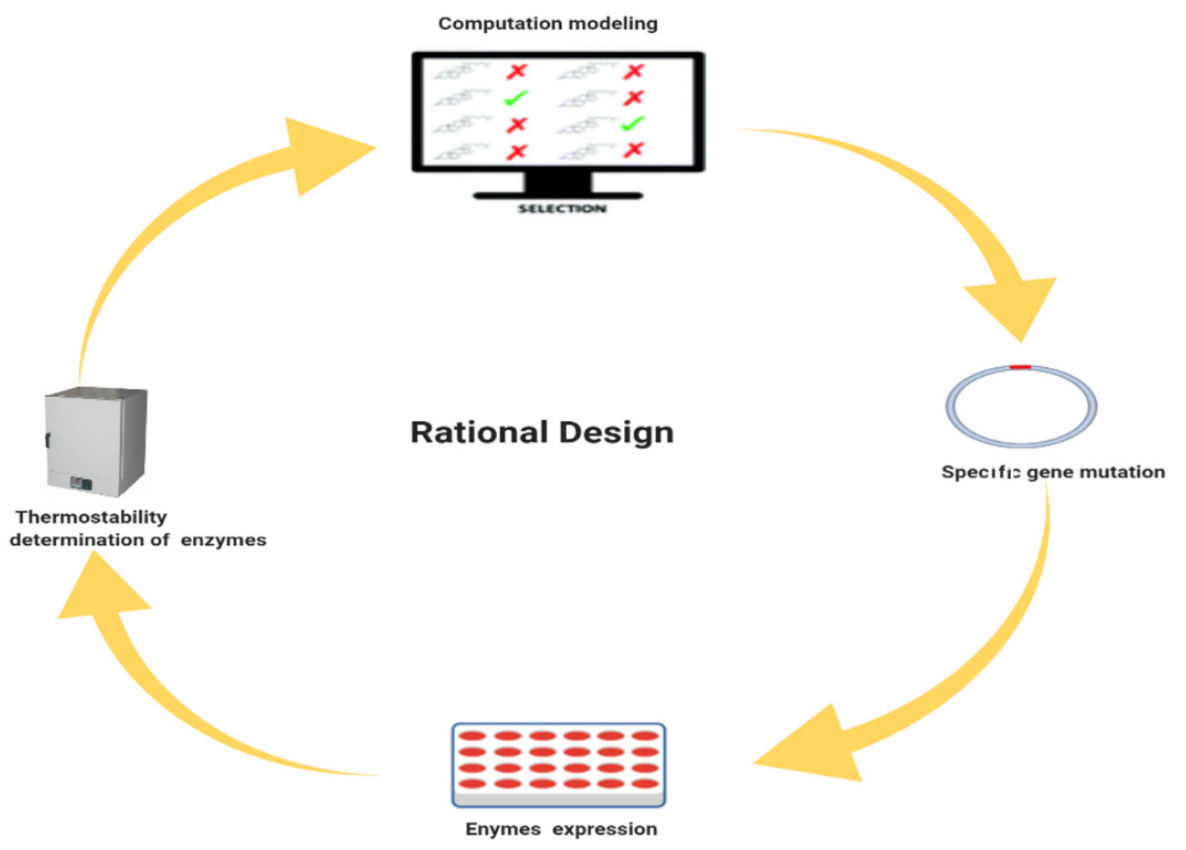
Figure 5. Schematic representation of the rational design, created by https://biorender.com web tool. Table 3. Engineered thermostable enzymes generated through rational design strategy.